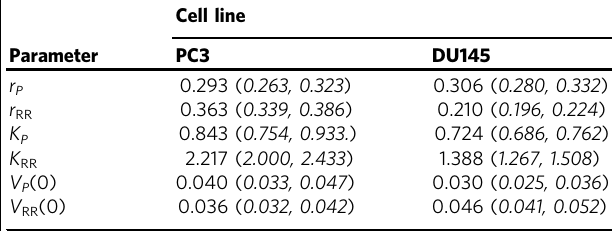
Values indicate mean value and 95% con fi dence intervals (in italics). P parental, RR